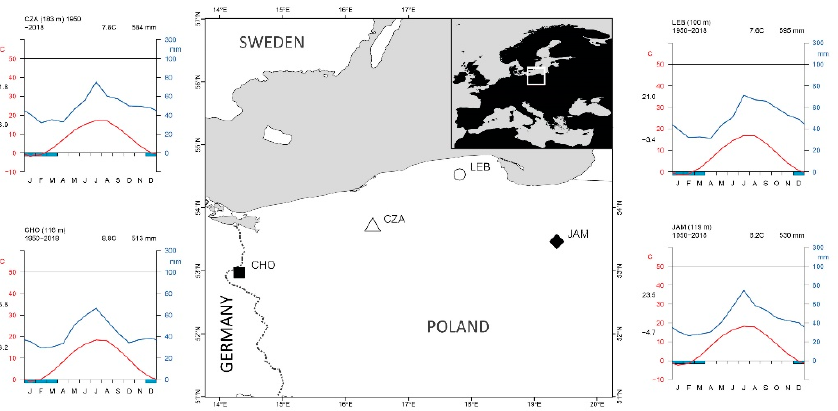
Figure 1. Locations of Douglas fir stands and climatic diagrams. Plots of the precipitation and temperature monthly averages, annual averages of both elements (in the upper part) and monthly averages of the daily maximum and minimum temperatures of the warmest and coldest months, respectively (at the left margin); blue rectangle under the 0 ◦ C axis—frost likelihood; JAM—Jamy, LEB — L ę bork, CZA — Czaplinek and CHO — Chojna.